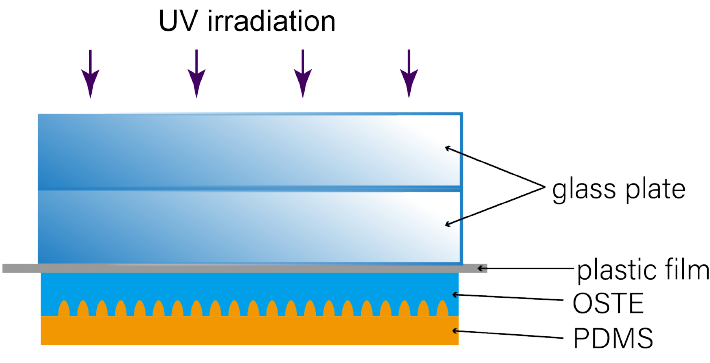
Figure A1. Fabrication setup of molding OSTE on